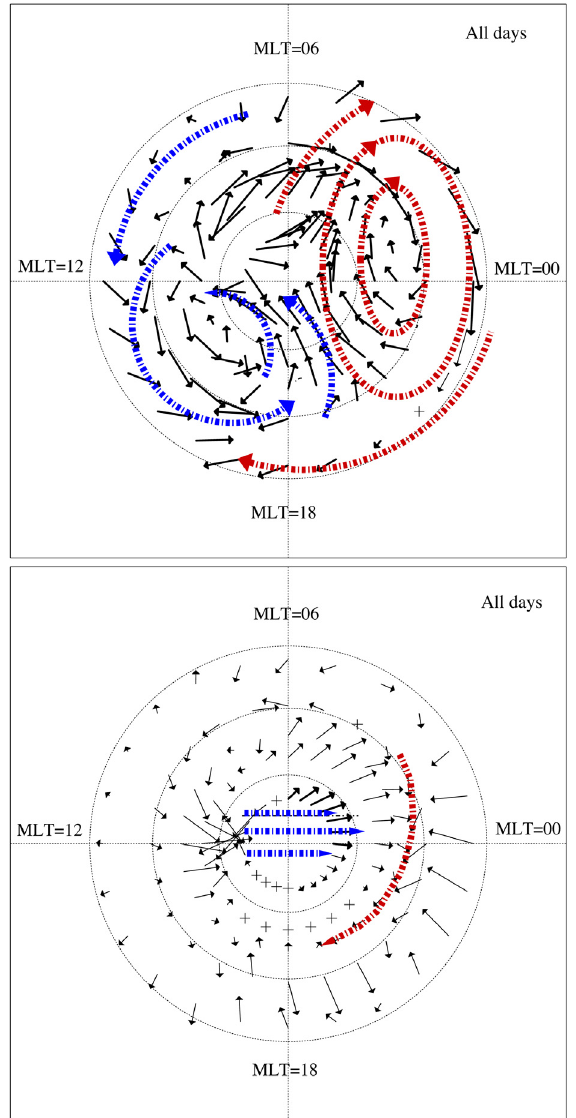
Figure 3. Polar diagrams of equivalent current vectors in the North- ern Hemisphere. Coordinates are magnetic latitude from 60° to the North magnetic pole, and MLT. The equivalent current vectors are calculated by means of the first EOFs on the top panel and the sec- ond EOFs on the bottom panel. The three circles mark, from the outermost one, the latitude of 60°, 70°, and 80° N, respectively.